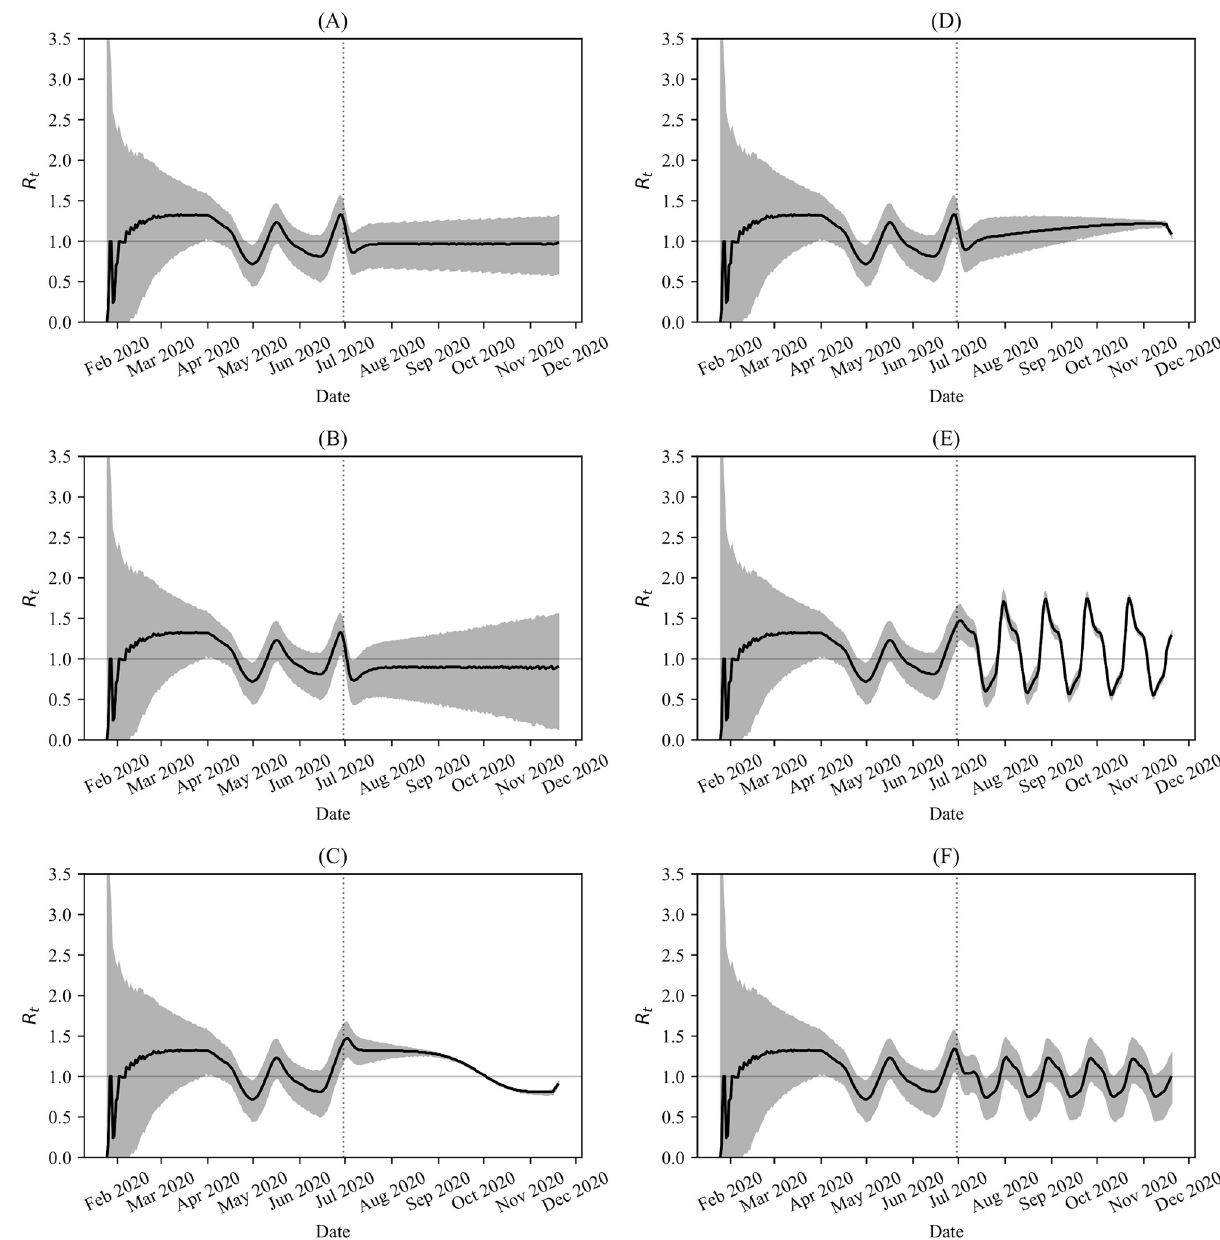
Fig 10. Predicted R t evolution for various public-responses. Plot shows R t for the future θ ( t ) schedules ( t > t n ) presented in Fig 5, obtained using the Bayesian method described in Ref. [14] along with the Distancing-SEIRD model. Grey area represents the 95% confidence interval about the mean values in black. The dotted vertical line indicates t n = 157 (June 30th), the time value corresponding to the last epidemiological data point used from Ref. [7].